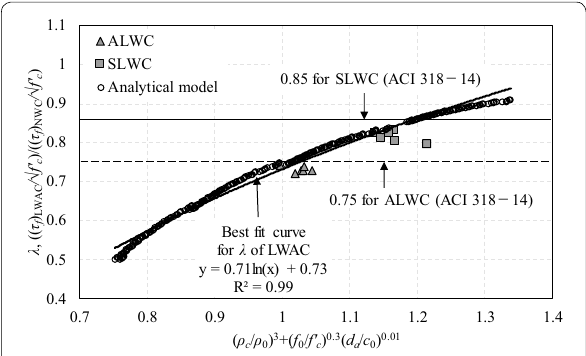
Fig. 10 Generalization of modification factor for